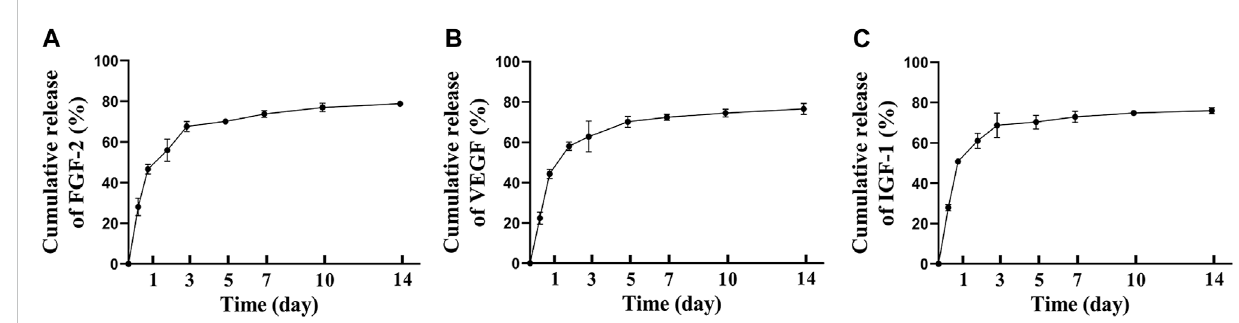
FIGURE 3 ControlledreleaseofMSCssecretomefrom fi bringlue invitro .ThecumulativereleaseofFGF-2 (A) ,VEGF (B) ,IGF-1 (C) fromMSCssecretome-loaded fi brin glue; n = 3 per